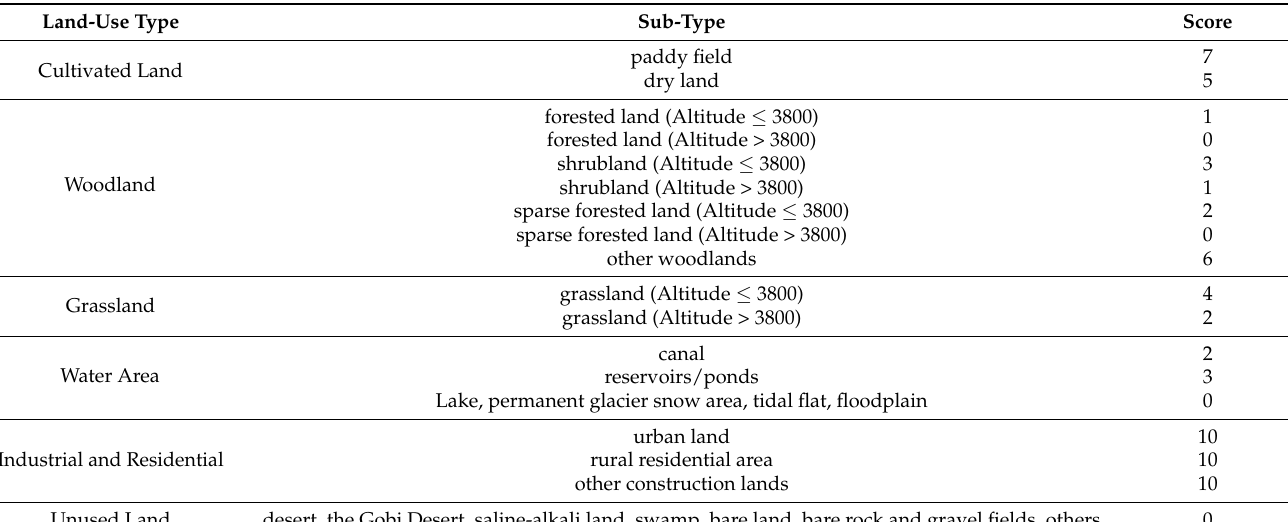
Table 5. The human influence scores assigned to each land use type based on relevant studies [30,31] and expert